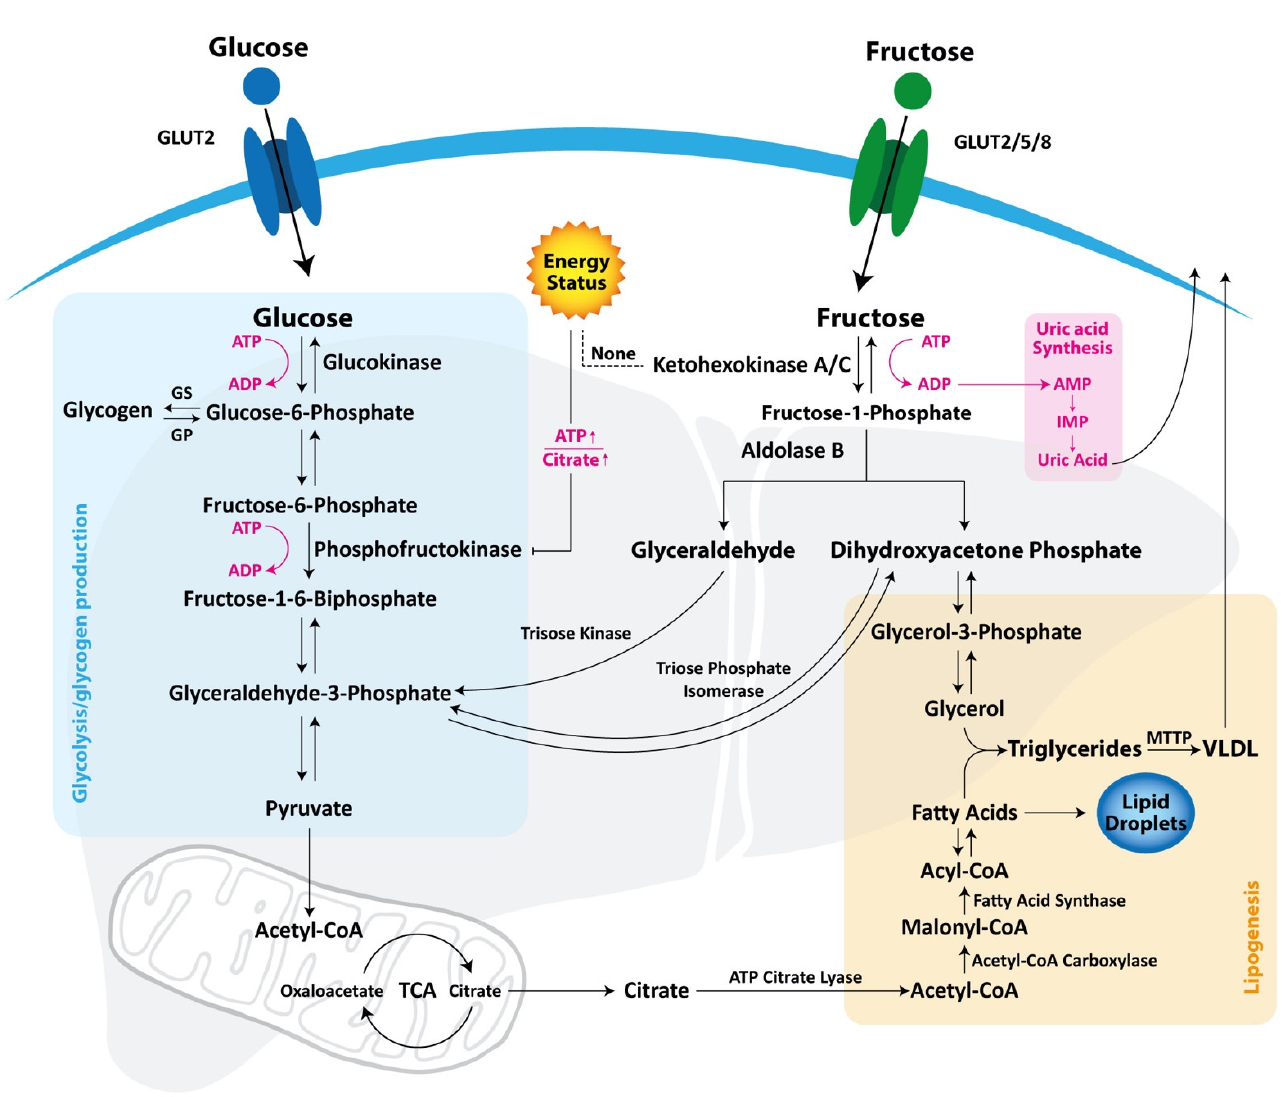
Figure 1. Glucose and fructose metabolism. Glucose is transported into the hepatocyte via GLUT 2 and is successively metabolized though glycolysis to produce ATP and pyruvate or is stored as glycogen. Fructose can be transported via GLUTs 2, 5, and 8 and is phosphorylated by ketohexokinase, A or C, into fructose-1-phosphate, that is cleaved in glyceraldehyde and dihydroxyacetone phosphate. While glucose metabolism is regulated by phosphofructokinase, which is inhibited by ATP and citrate when energy status is high, the ketohexokinase activity is unrestricted. Glyceraldehyde and dihydroxyacetone phosphate are phosphorylated, respectively, by triose kinase or triose phosphate isomerase in glyceraldehyde-3-phosphate to produce pyruvate for fuel triglyceride synthesis or fructose-1,6-biphosphate for gluconeogenesis. Dihydroxyacetone phosphate may be converted in glycerol-3-phosphate to production of triglycerides and VLDL lipoproteins. ADP, adenosine diphosphate; ATP, adenosine triphosphate, AMP, adenosine monophosphate; IMP, inosine monophosphate; Glut, glucose transporter; Gp, glycogen phosphorylase; Gs, glycogen synthase; MTTP, microsomal triglyceride transfer protein; TCA, citric acid cycle; VLDL, very low-density lipoprotein.